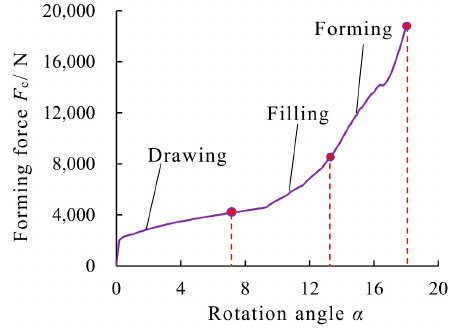
Figure 5. Forming force–angle curve during rotated clinching process.